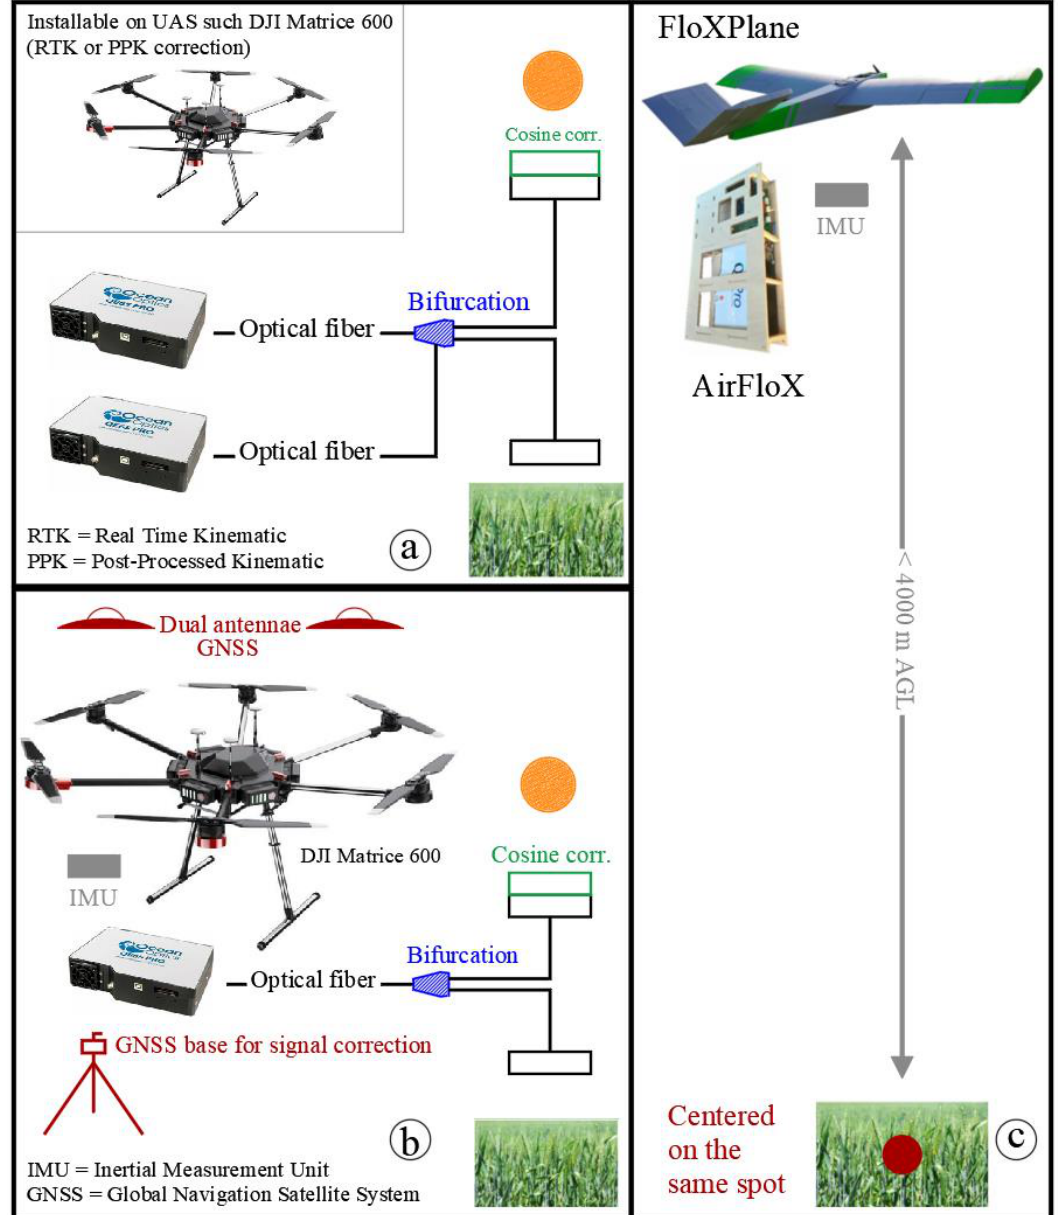
Figure 9. Schemes summarizing the main characteristics of ( a ) Piccolo-Doppio, ( b ) AirSIF, and ( c )